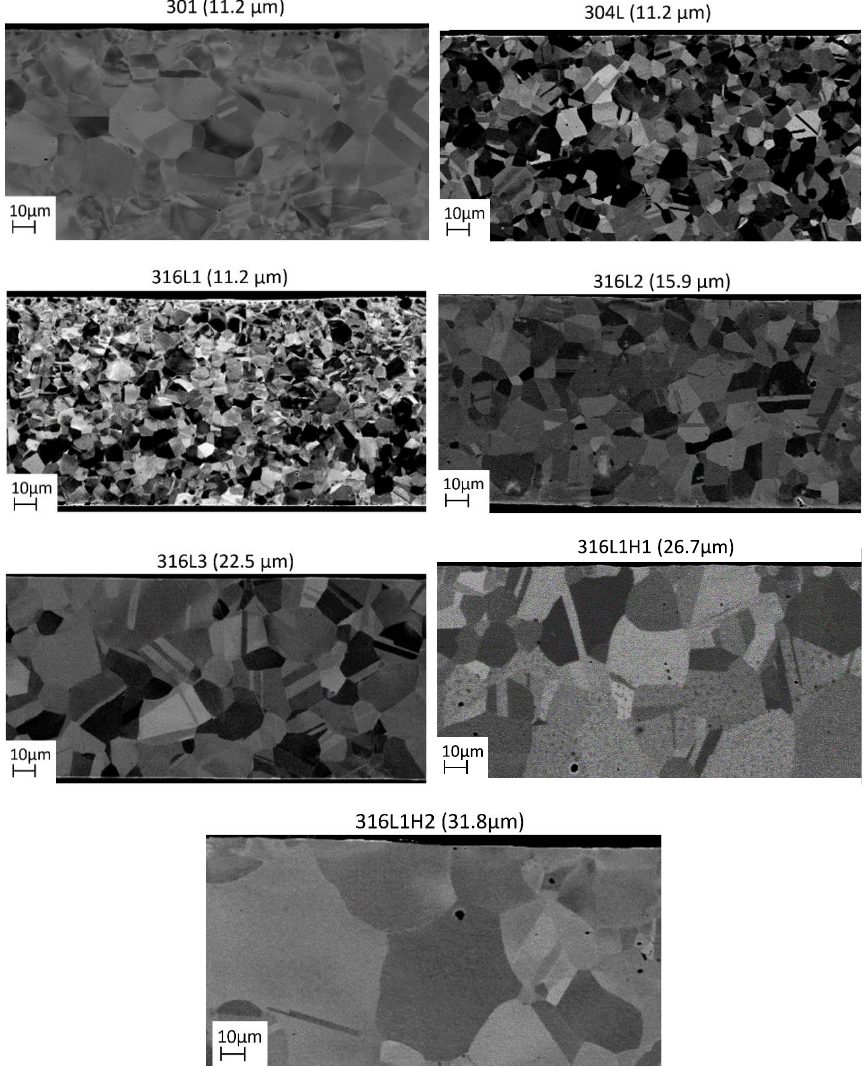
Figure 7. SEM microstructure images taken over the material thickness in the RD (Section 1 in Figure 1), with the averaged grain sizes measured for each particular alloy shown in brackets.